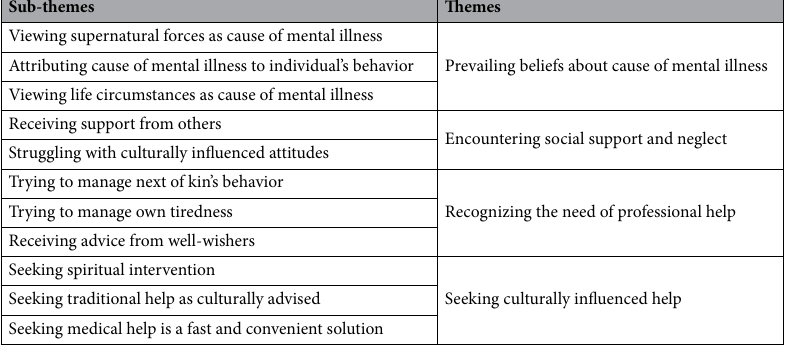
Table 2. An overview of the sub-themes and themes regarding experiences of family caregivers’ beliefs and practices when caring for next-of-kin with mental illness